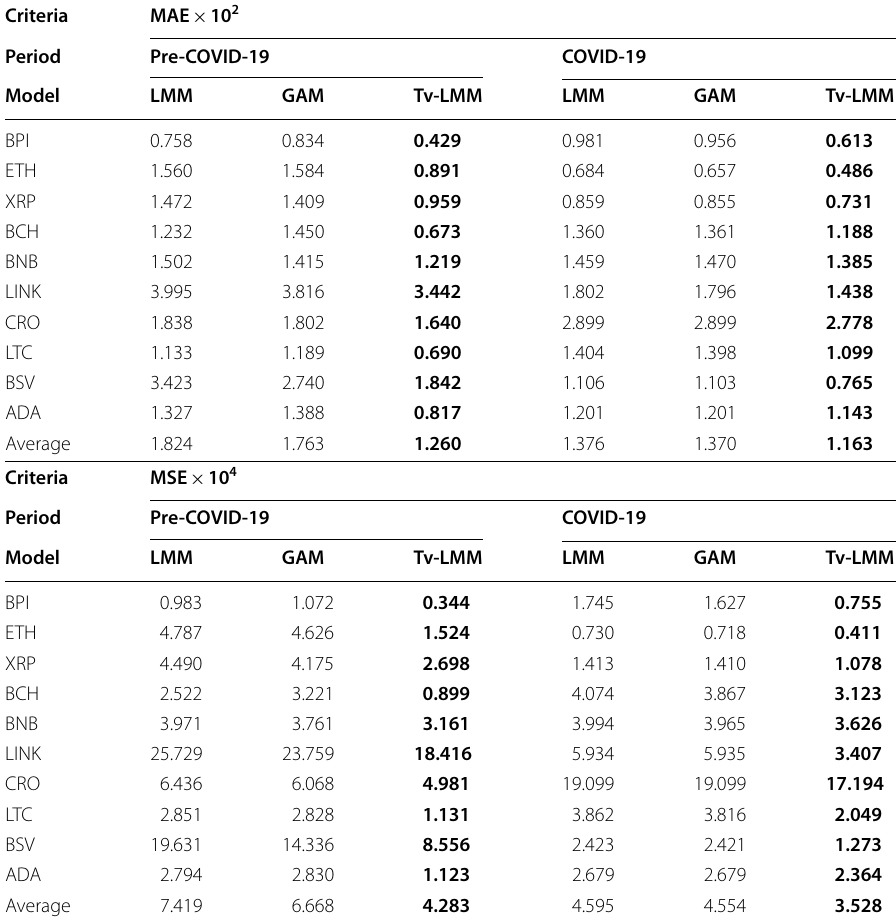
Bold values indicate the best predictability performance for cryptocurrency price in terms of the lowest MAE and MSE, respectively